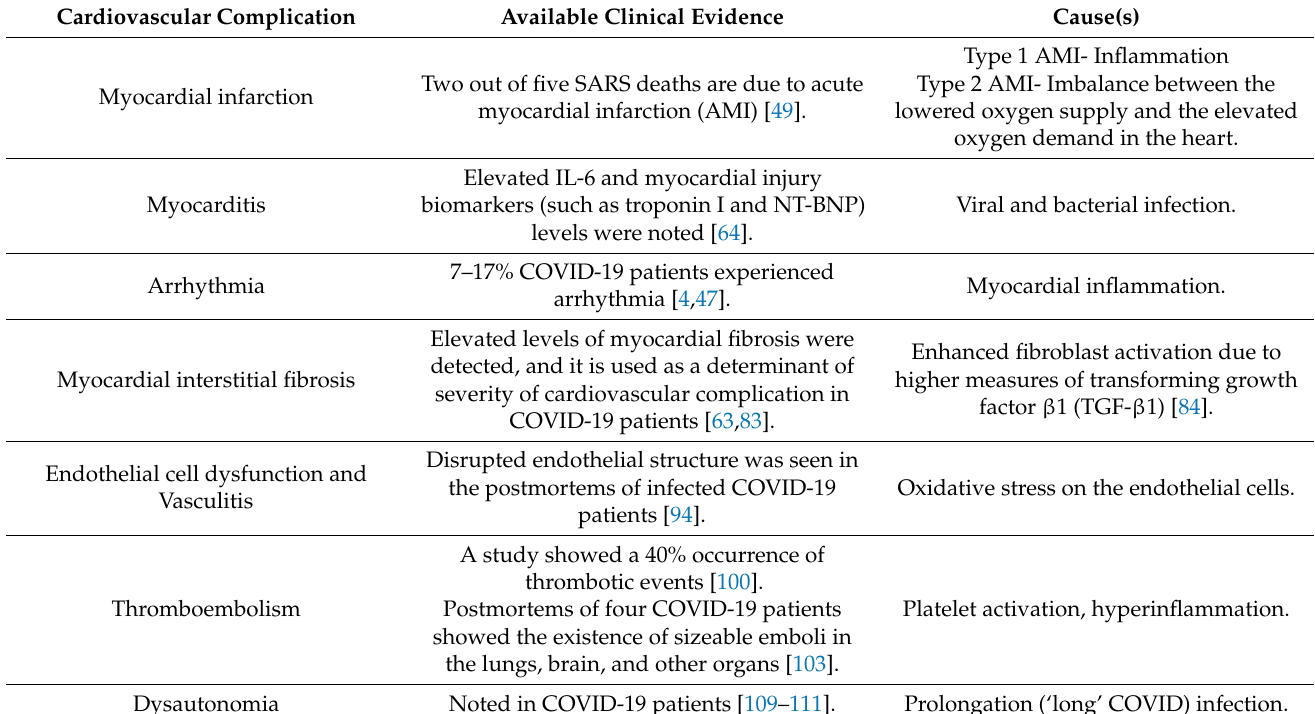
Table 1. Summary of cardiovascular complications noted in COVID-19